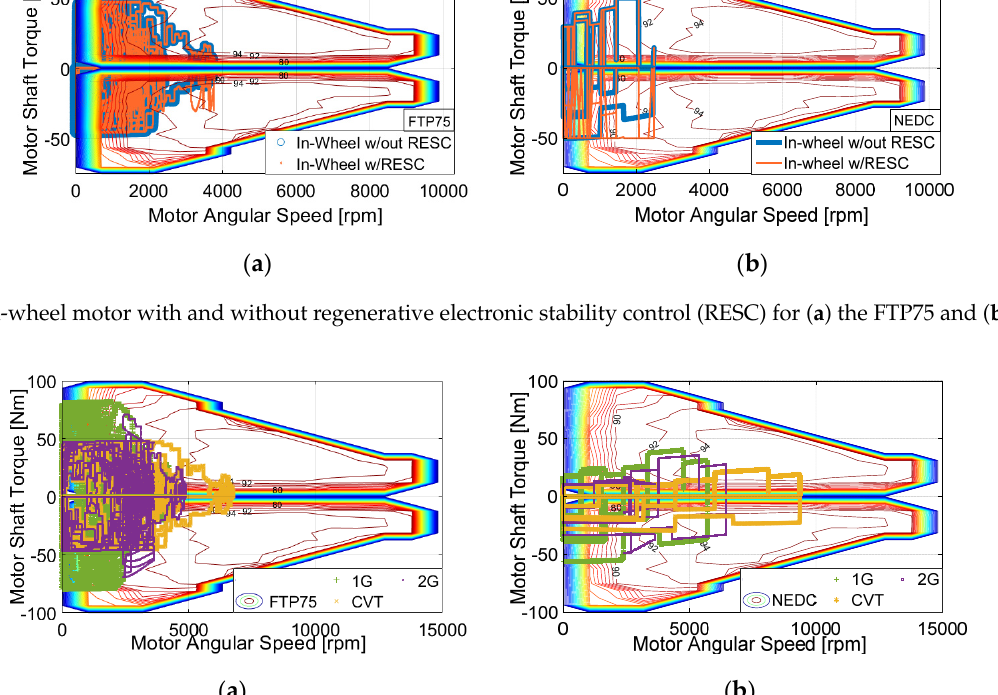
Figure 8. In-wheel motor with and without regenerative electronic stability control (RESC) for ( a ) the FTP75 and ( b ) NEDC.